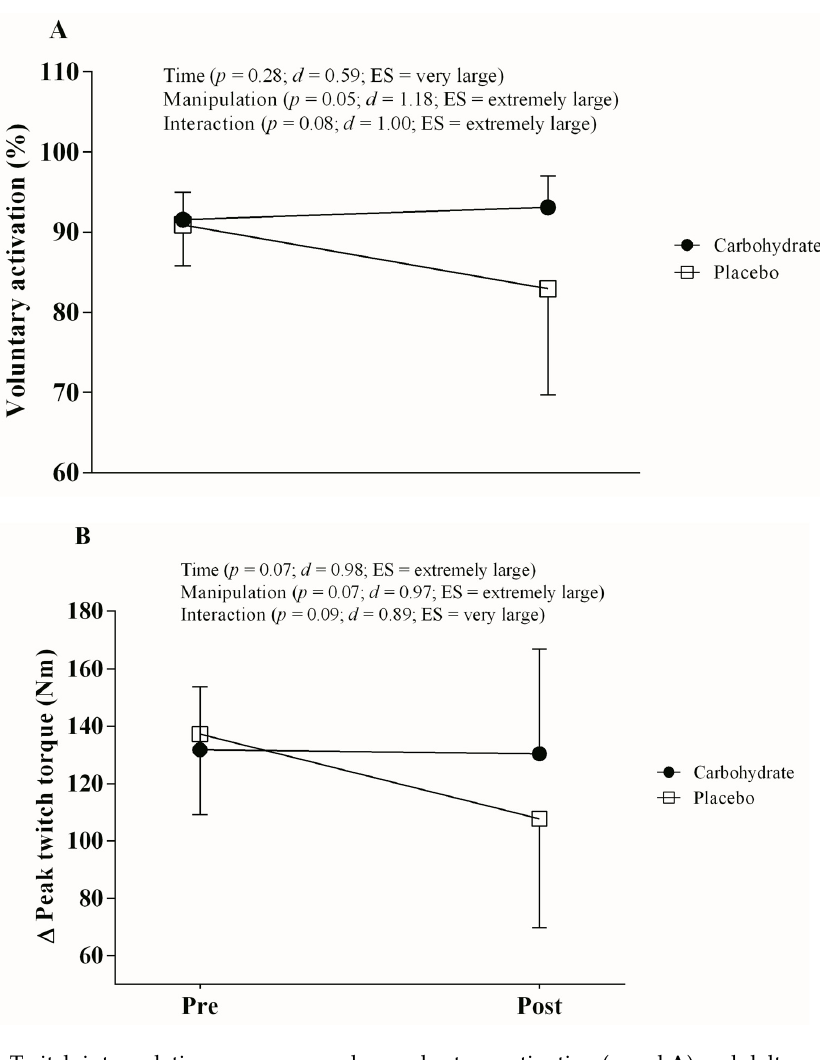
Figure 3. Twitch interpolation responses such as voluntary activation (panel A ) and delta peak twitch torque (panel B ) measured before and after TT 4km in carbohydrate (filled circles) and placebo mouth rinse (open squares).